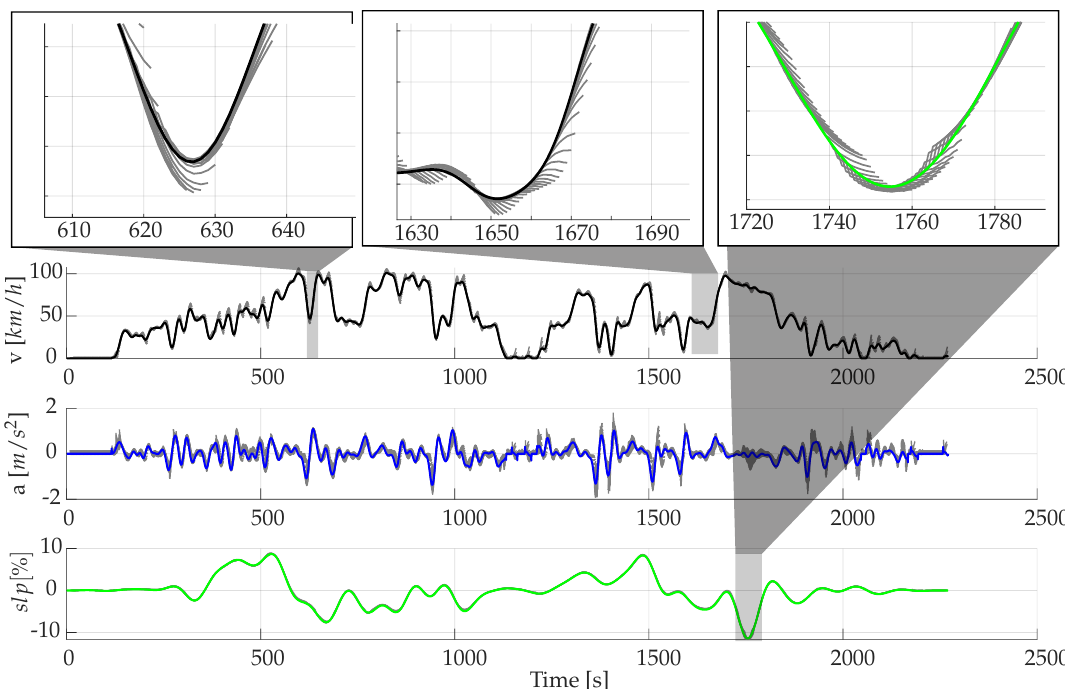
Figure 12. Predictions using FNN including slope [Driver 1/10 s prediction